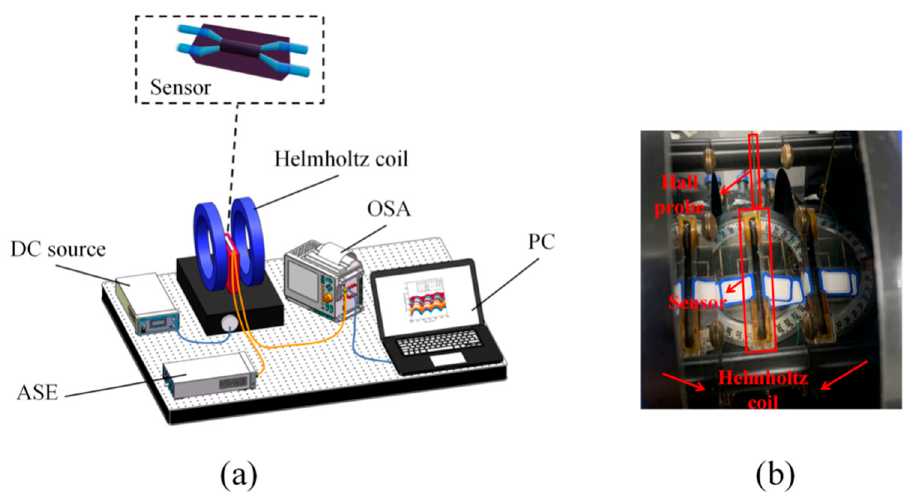
Figure 4. ( a ) Diagram of magnetic field test system. ( b ) The sensor is placed in Helmholtz coils. First, sample 1 with the structural parameters of OMC as R of 3.5 µ m and L of 9